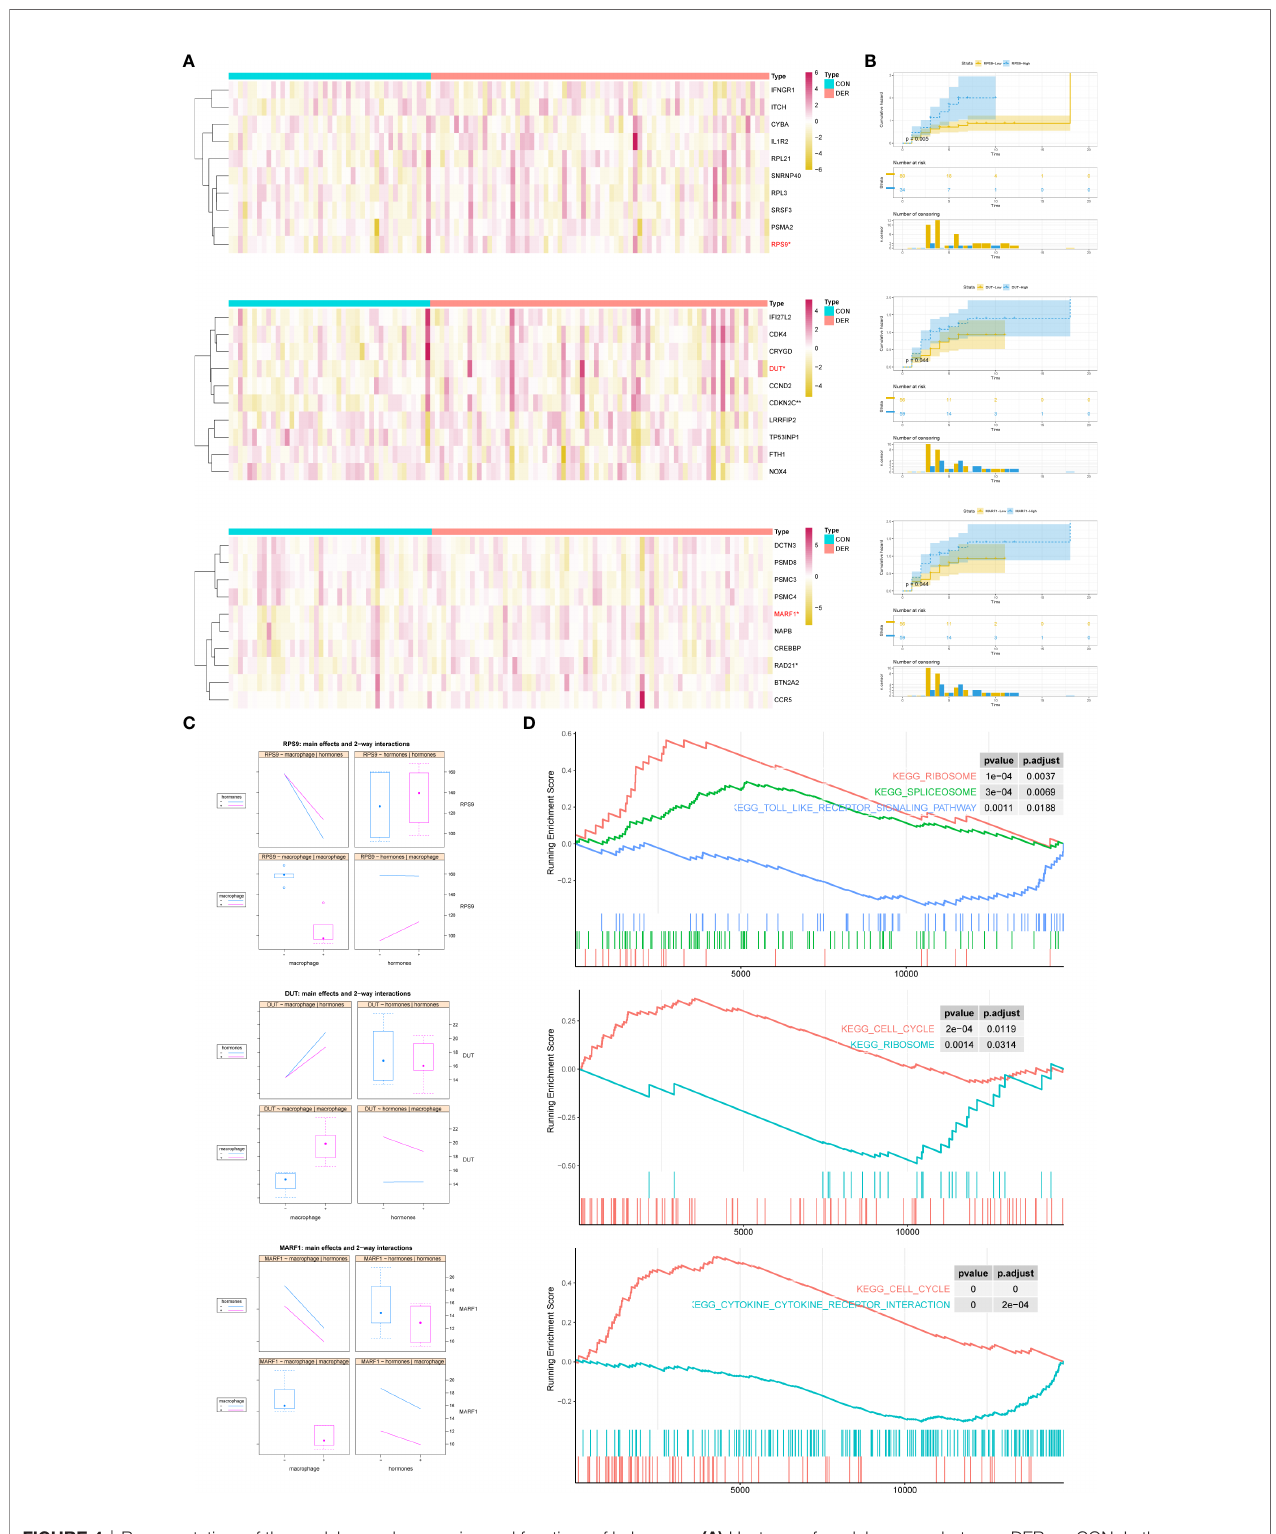
FIGURE 4 | Representatives of the modules, and expression and functions of hub genes. (A) Heatmap of modules genes between DER vs. CON. In the classi fi cation column, red represents infertilities, whereas blue represents controls. (B) Cumulative risk curves of pregnant status analysis for hub genes. Log-rank p = 0.005 (RPS9), 0.044 (DUT), and 0.044 (MARF1) denotes the signi fi cance of hub genes. (C) Main effects and two-way interactions of hub genes. (D) GSEA plot of upregulated and downregulated KEGG pathways related to changes in hub gene expression levels. CON, control; DER, defective endometrial